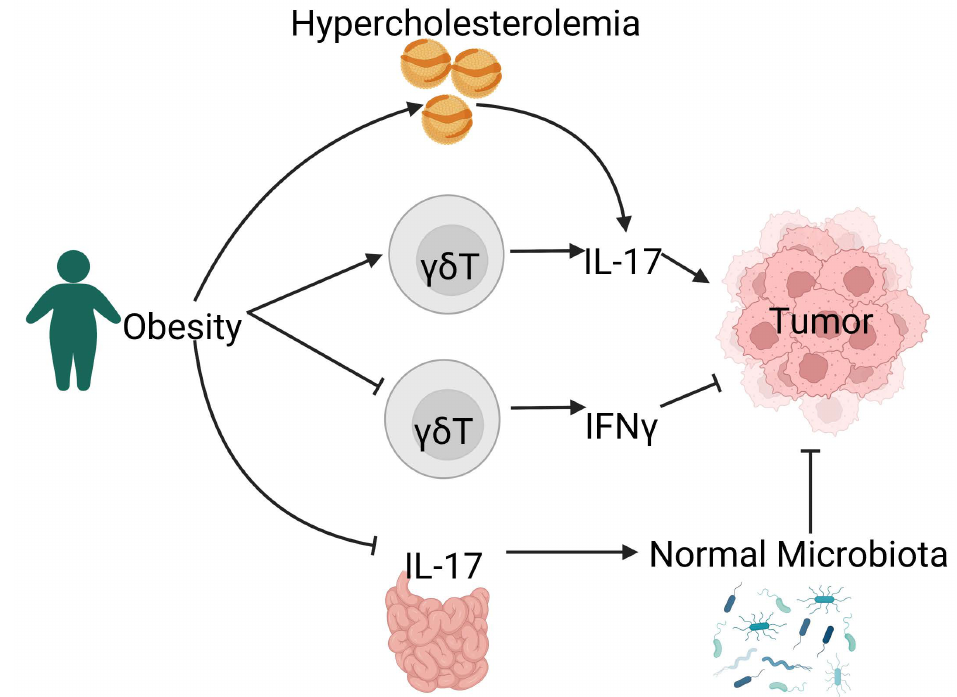
Figure 2. IL-17 bridges metabolic disorders and